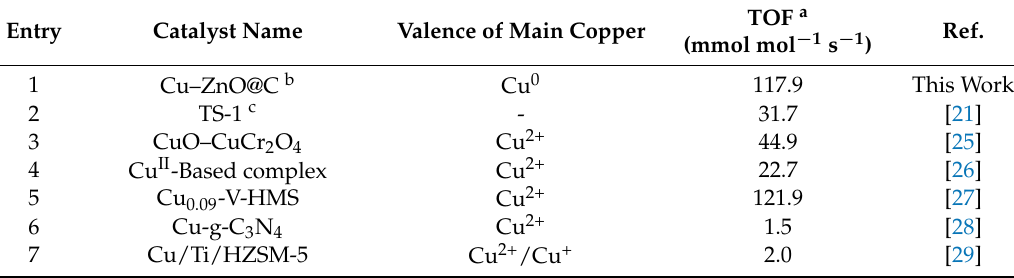
Table 4. Comparison of the catalytic hydroxylation of benzene to phenol of the reported Cu–ZnO@C catalysts with literature